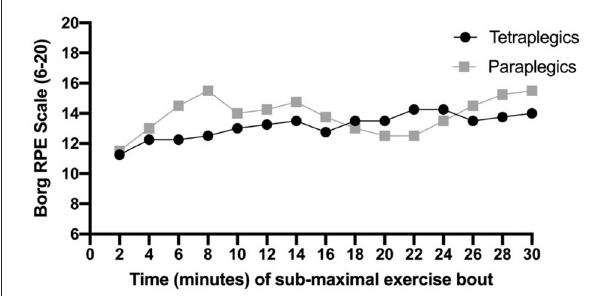
FIGURE 2 | Average of participants’ RPE at 2-min intervals throughout the sub-maximal exercise bout.